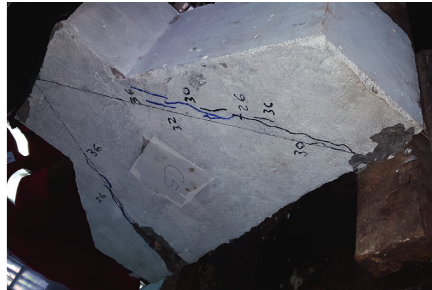
Figure 4: The failure mode for corbel